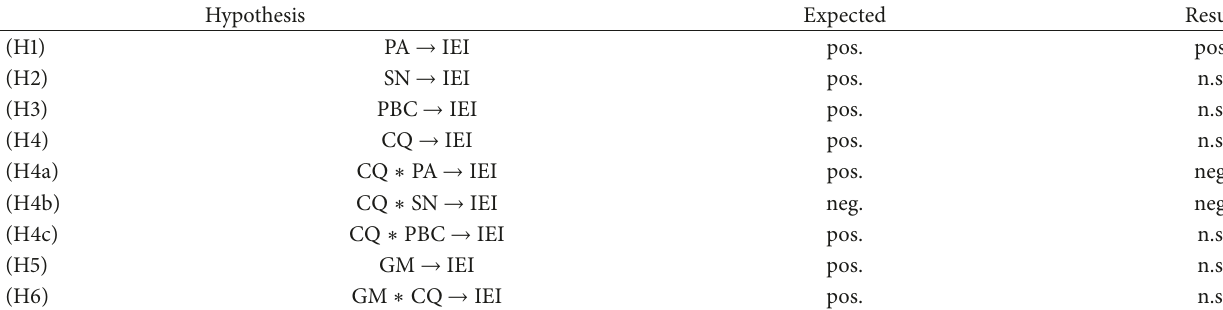
Table 7: Summary results of hypothesis tests.